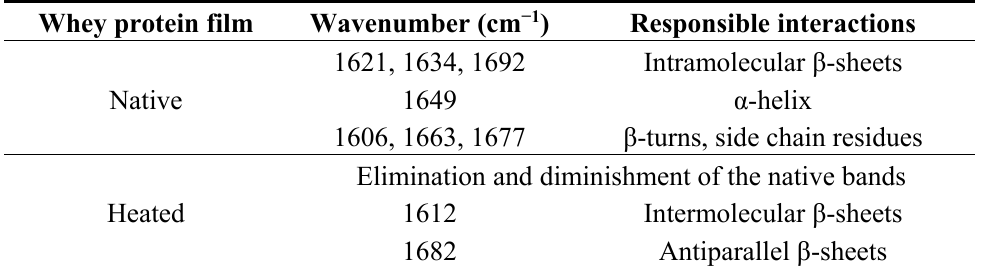
Table 3. Structural changes in the amide I region of the Fourier Transform Infrared (FTIR) spectra of whey protein films in consequence of thermal denaturation